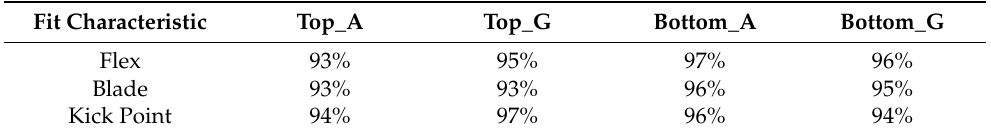
Table 7. Accuracy of various fine KNN models trained using top and bottom hand linear acceleration (_A) and angular velocity (_G) data for wrist shot speed.